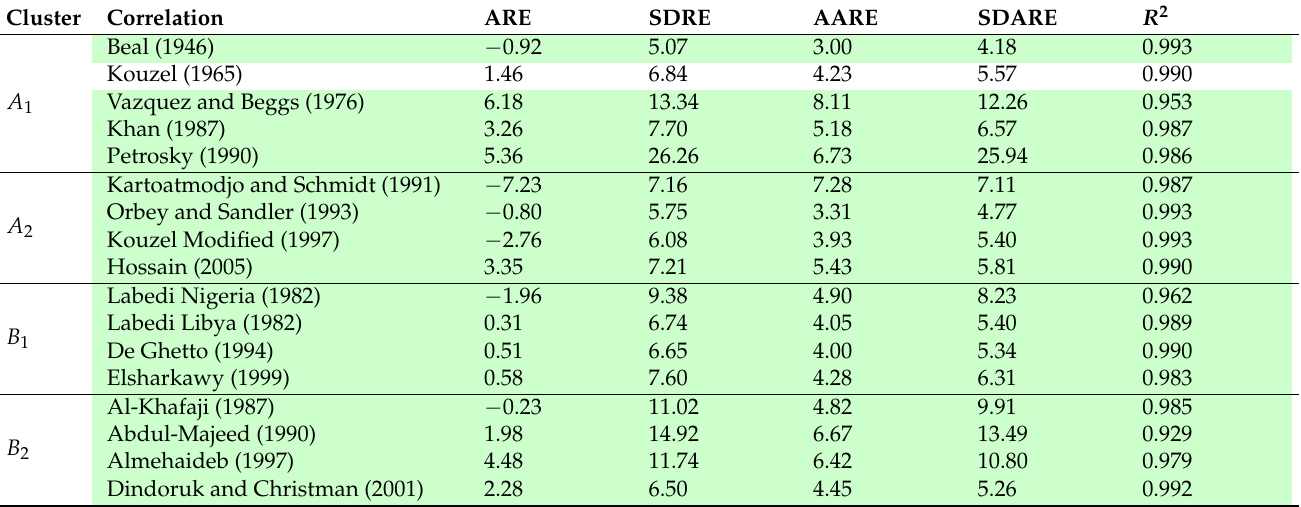
Table A1. Detailed metric values for all correlations and for µ ob range 0–1.